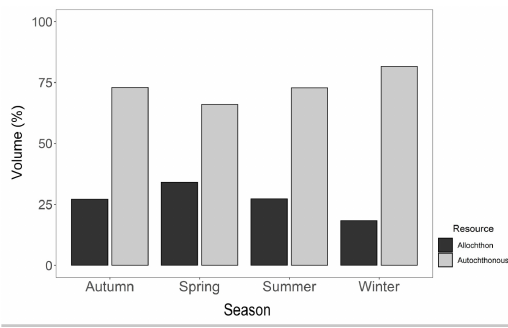
Figure 5. Origin of food resources that constituted the Serrapinnus notomelas diet in the coastal zone of a marginal lagoon on the Tibagi River, Upper Paraná River Basin, sampled from February 2017 to January 2018.